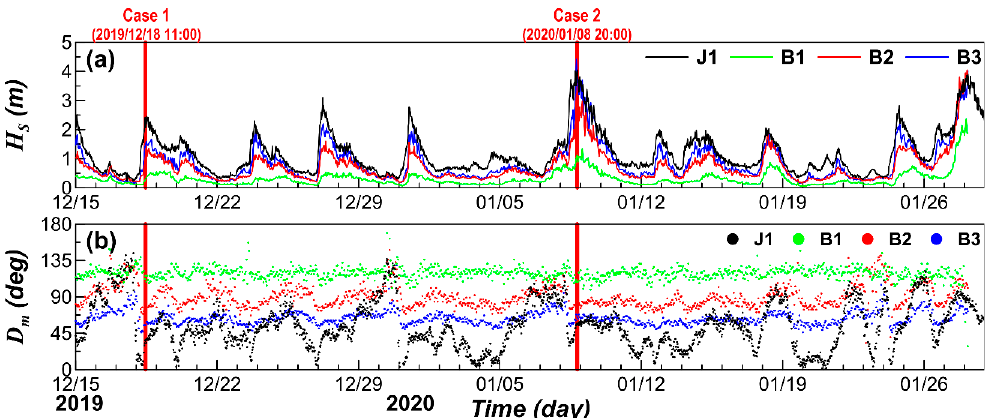
Figure 5. Time variations of the wave parameters during the field experiment: ( a ) significant wave height ( H s ) and ( b ) peak wave direction ( D m ) calculated from the wave spectra measured at the four wave stations shown in Figure 1b. Black: J1; green: B1; red: B2; blue: B3.